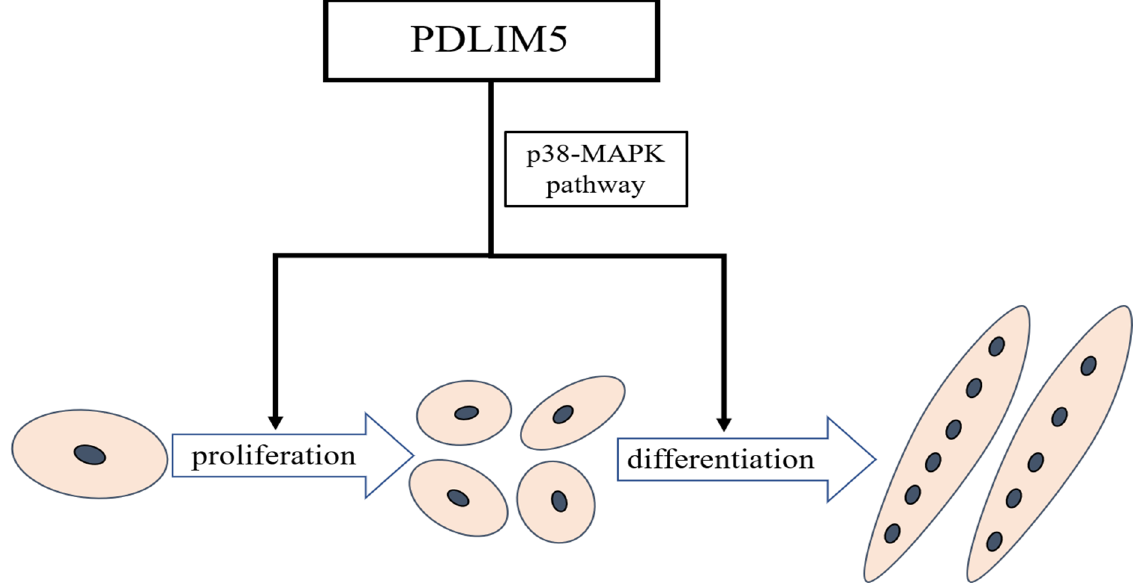
Figure 6. Schematic diagram of PDLIM5 regulating chicken skeletal muscle satellite cell proliferation and differentiation. Supplementary Materials: The following are available online at www.mdpi.com/xxx/s1, Table S1: